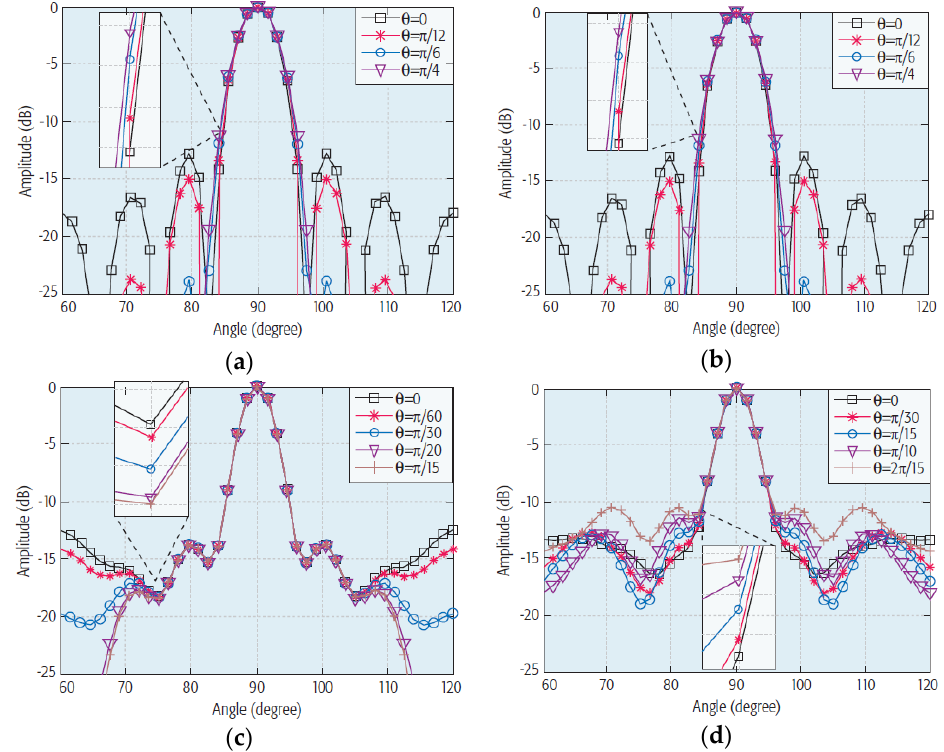
Figure 15. 2D radiation plots of ( a ) 8 × 8 rectangular element array, ( b ) 16 cross ‐ shaped element array, ( c ) 64 circular element array, and ( d ) 61 hexagonal element array (Redrawn from [9]).